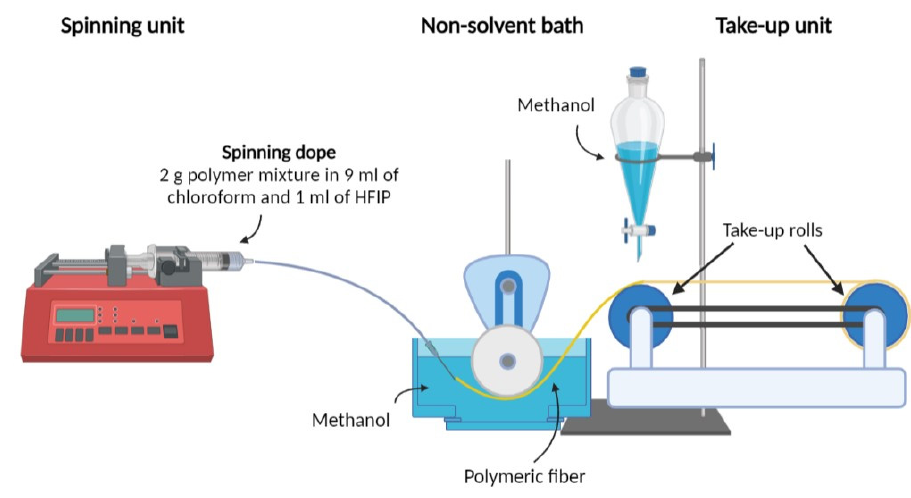
Figure 1. Schematization of the wet spinning set − up used for fiber production.